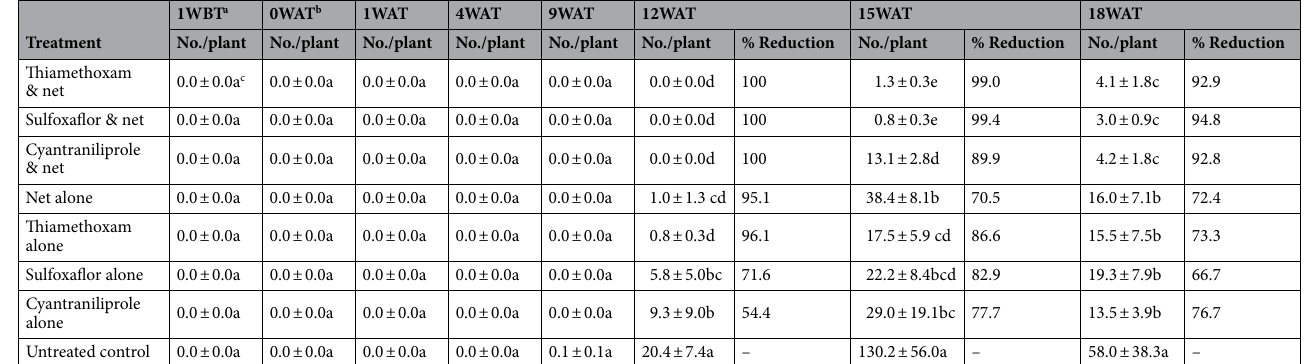
Table 1. Effects of different treatments on Bemisa tabaci adult populations during the whole growing season (greenhouse trial I, 2018). a WBT, weeks before transplanting; 1 WBT is the time of root drenching. b WAT, weeks after transplanting; 0 WAT is the time of seedling transplanting; 12 WAT is the time of first fruit harvest; 18 WAT is the end of the greenhouse trials. c In the columns, the data are the means ± SD of four replications, with 10 plants per replicate. Means followed by the same letter are not significantly different at P = 0.05 level according to the LSD